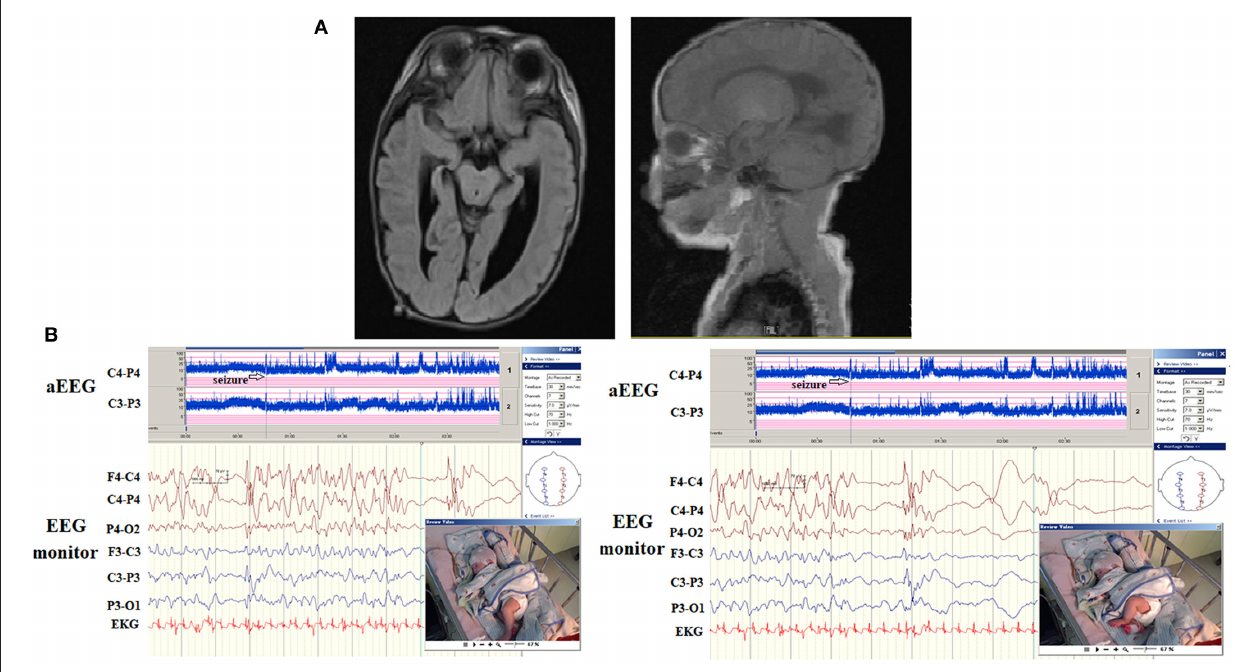
FIGURE 2 | (A) A patient had a congenital structural brain malformation with asymmetrical and irregular size of ventricles, and suspected focal cortical dysplasia. His first seizure onset was at 2 months of age with bilateral alternative clonic seizures of legs. (B) The aEEG detected frequent seizures and electroencephalography (EEG) monitoring detected irregular spikes occurring in the right and left hemispheres (upper, arrows) associated with left and right clonic seizures independently.